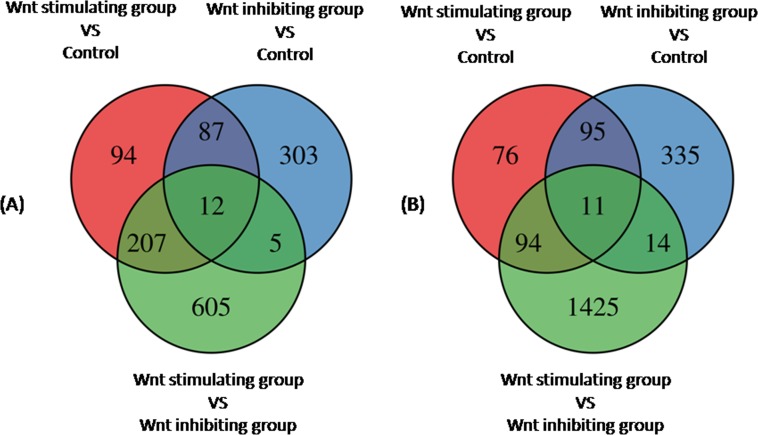
Venn diagrams of differentially expressed genes between different groups.(A) Up-regulated genes between groups. (B) down-regulated genes between groups. The diagram showing the intersection of genes differentially expressed between Wnt stimulating groups and control (red), between Wnt inhibiting group and control (blue), between Wnt stimulating group and Wnt inhibiting group (green). FDR-adjusted p-value<0.05 and fold-change >2.0.